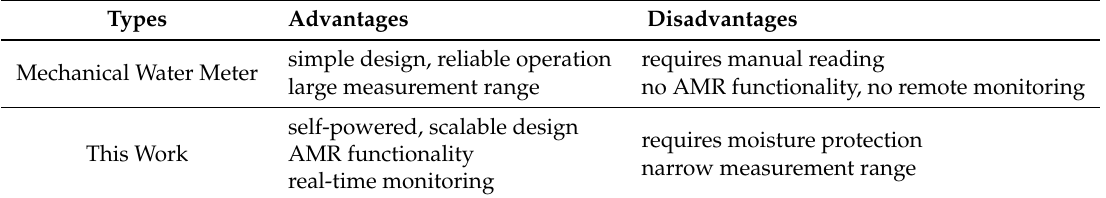
Table 6. Comparison of the proposed smart meter and traditional mechanical water